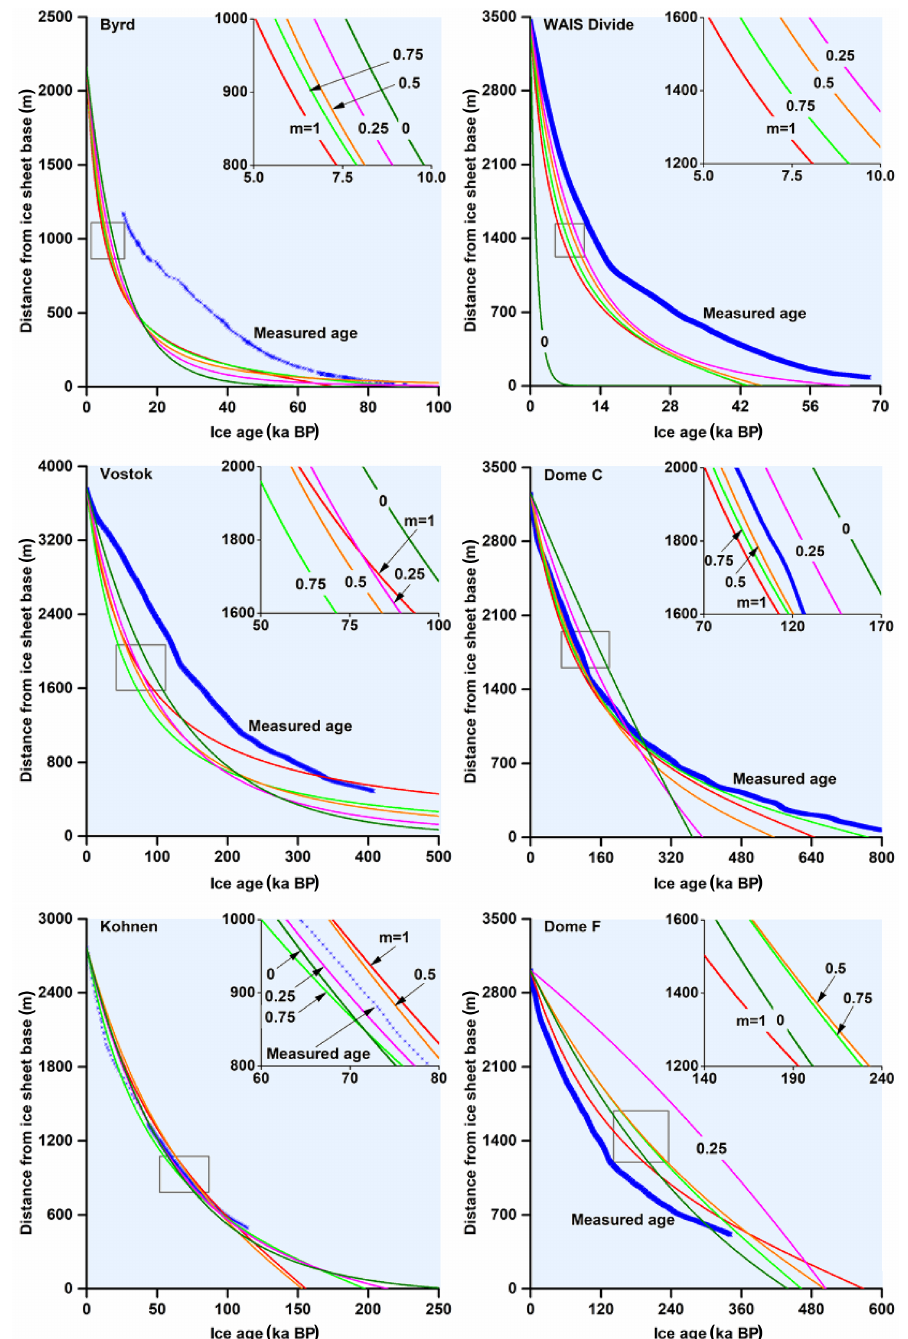
Figure 4. Comparison of the measured age scales (Ahn and Brook, 2008; Bazin et al., 2013; Bereiter et al., 2012; Blunier and Brook, 2001; Kawamura et al., 2007; Neftel et al., 1988; Parrenin et al., 2007b; Sigl et al., 2016; Staffelbach et al., 1991; Veres et al., 2013) and modeled age scales with m = 0, m = 0.25, m = 0.5, m = 0.75, and m = 1.0 (correlation factors between modeled and measured age scales for each run are stated in Table